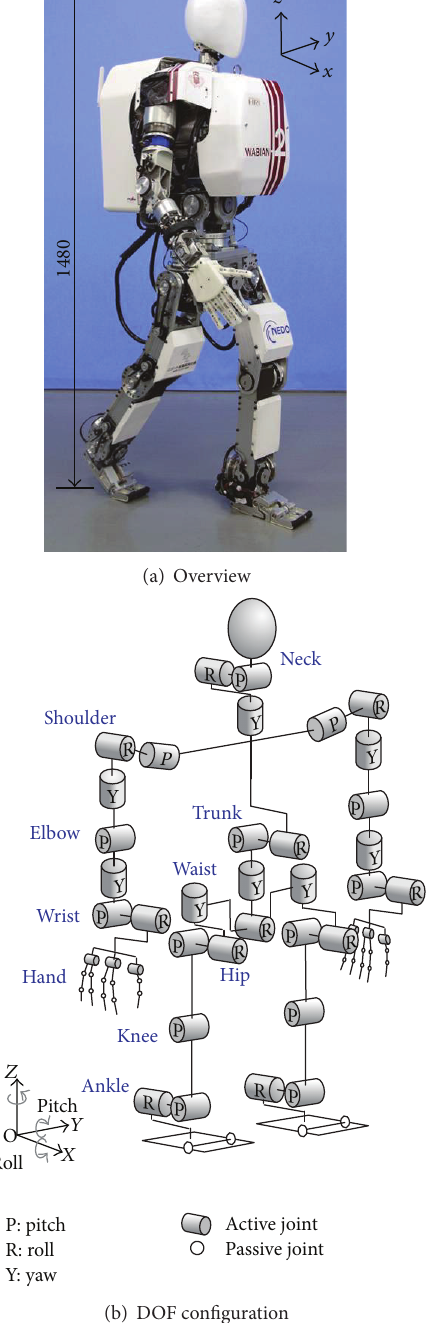
Figure 1: WABIAN-2R (Waseda Bipedal Humanoid—No. 2 Refined).